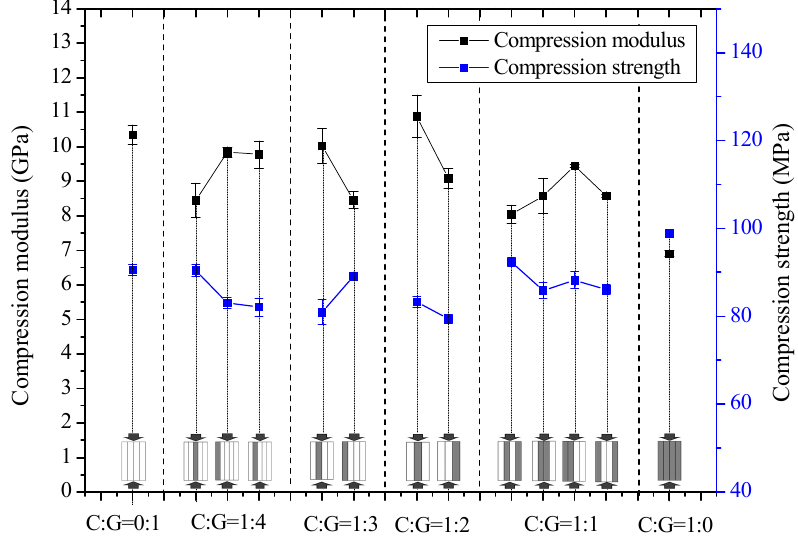
Figure 7. 90-degree direction compression modulus and strength of different stacking sequences with various C/G ratios.